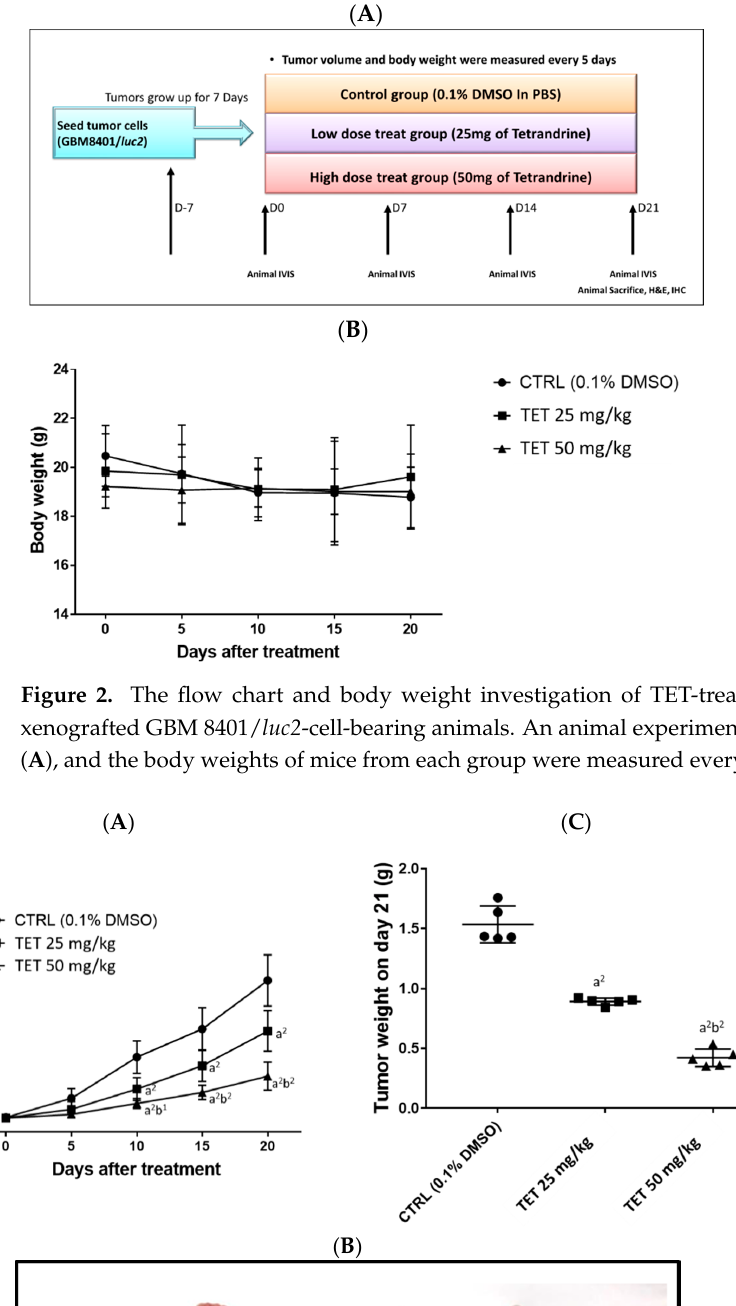
3 of 14 named GBM 8401/ luc2 cells, and significantly suppressed and reduced tumor growth in vivo. 2. Results 2.1. The Effects of TET on Cell Viability and Apoptosis in GBM 8401/luc2 Cells GBM 8401/ luc2 cells were treated with TET, and the cells were harvested for measur- ing the cell viability and apoptosis using a flow cytometer, and the results are shown in Figure 1. TET at 10–25 μ M significantly decreased 8.35–98.16% of the total viable cell num- ber (cell viability) (Figure 1A); however, TET at 10–20 μ M induced apoptotic cell death in 23.81–74.59% of cells (Figure 1B). These effects are dose-dependent. ( A ) ( B ) Figure 1. The effect of TET on cell viability and apoptosis in GBM 8401/ luc2 cells. Cells (1 × 10 5 cells/well) were incubated with TET (0, 10, 15, 20, and 25 μ M) for 48 h, and cells were harvested and measured for cell viability ( A ) and apoptosis ( B ) using a flow cytometer as described in Materials and Methods. Data are expressed as mean ± standard error. Comparisons between control and TET- treated groups were performed using one-way ANOVA. (a 1 p < 0.05 and a 2 p < 0.01 vs. control). 2.2. TET Affected Body Weights and Glioblastoma Tumor Growth In order to investigate the anti-tumor activity of TET in vivo, the glioblastoma (GBM